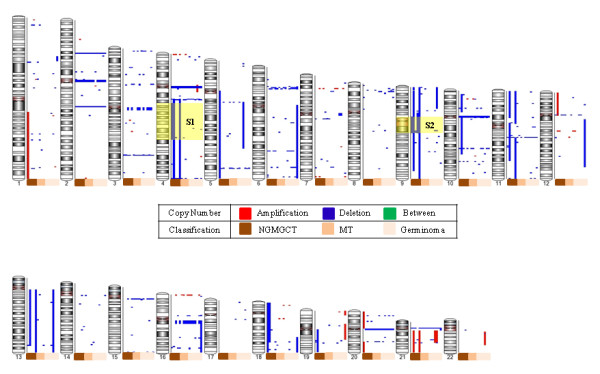
Chromosomal aberrations in the TW germinomas, mature teratomas (MTs) and NGMGCTs. The red bars on the right side of the chromosome idiograms indicate gain in these chromosomal regions, while blue bars indicate chromosomal loss. Two common copy number variation (CNV) regions (S1 & S2) in 3 out of 5 NGMGCT cases are highlighted.